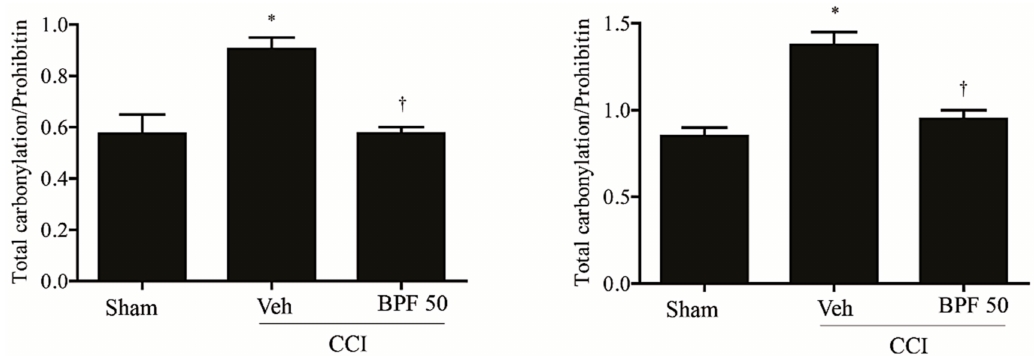
Figure 5. The increase of 4-HNE level cause carbonylation of mitochondrial proteins. High 4-HNE levels induced carbonylation of mitochondrial proteins either 14 days ( A ) and 21 days ( B ) post injury in CCI-only rats. Subcutaneous infusion of BPF (50 mg / kg), concurrently with surgery (day 0), prevented mitochondrial proteins carbonylation. In these conditions, prohibitin expression appeared statistically the same among groups. Gels are representative of results from 6 animals. Densitometric analyses of all animals per groups are reported. Results are expressed as mean ± SEM for 6 rats. * p < 0.05 compared to sham; † p < 0.05 compared to vehicle + CCI. Antioxidants 2020 , 9 , x